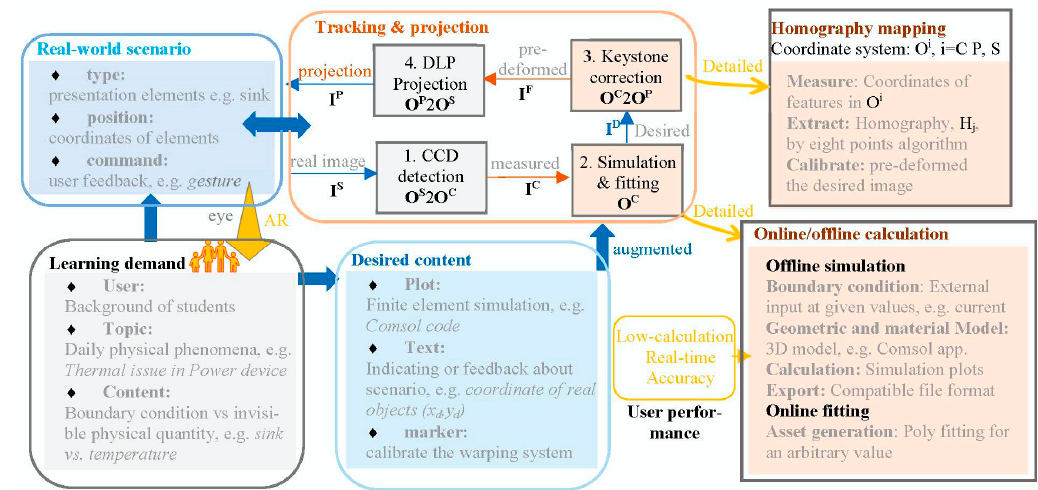
Figure 5. Data pipeline of the DLP-based AR learning design from the learning demand to the real-world scenario, and the desired image under the conditions defined by user operation through the suggested tracking and projection block, where the pre-deformed image IF is generated by homography mapping method, and the desired simulation ID is calculated by the simulation and fitting.